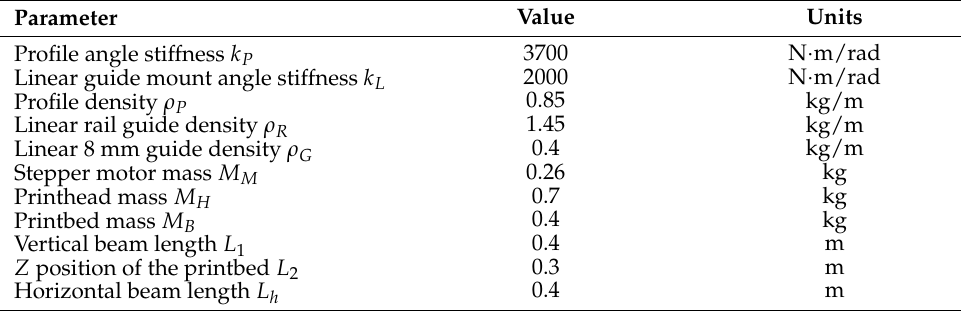
Table 2. Parameters of the evaluated design.